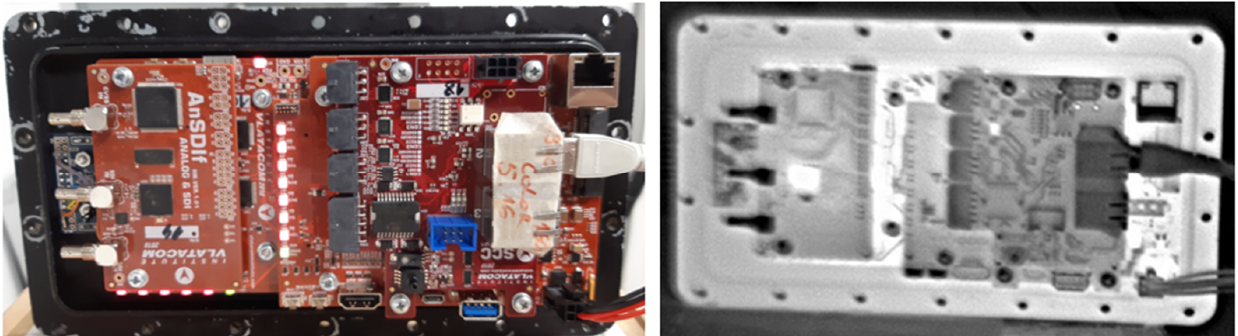
Figure 16. VVSP module top view filmed with lowlight and thermal camera .